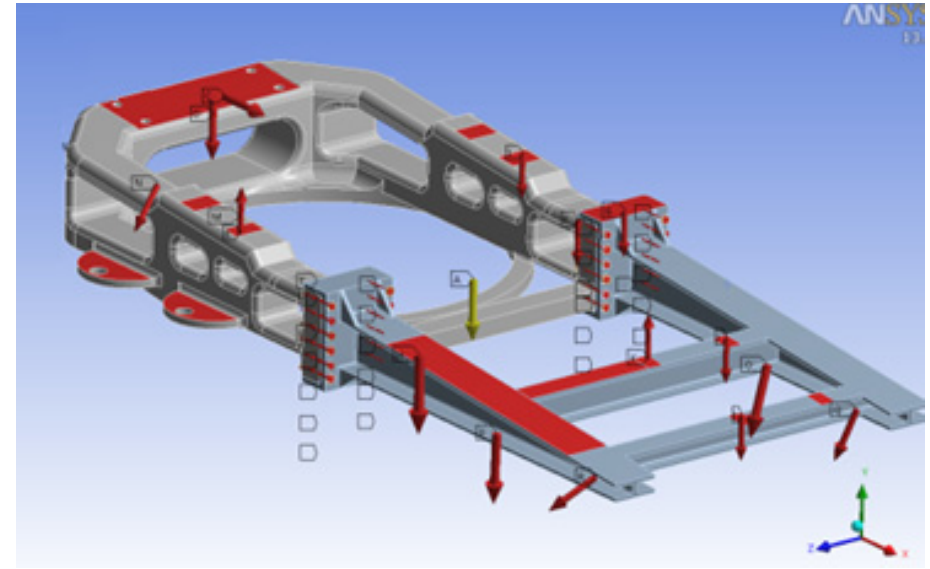
Figure 7. Full loadings on the bedplate [30] .